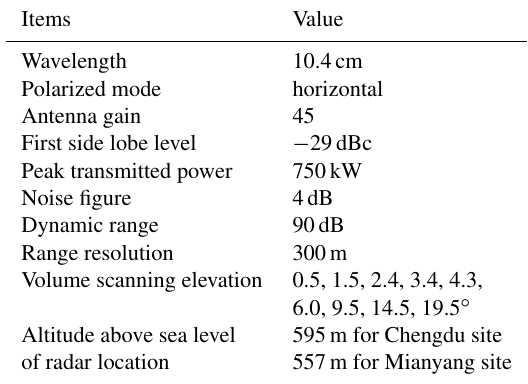
Table 1. Characteristics of S-band Doppler weather